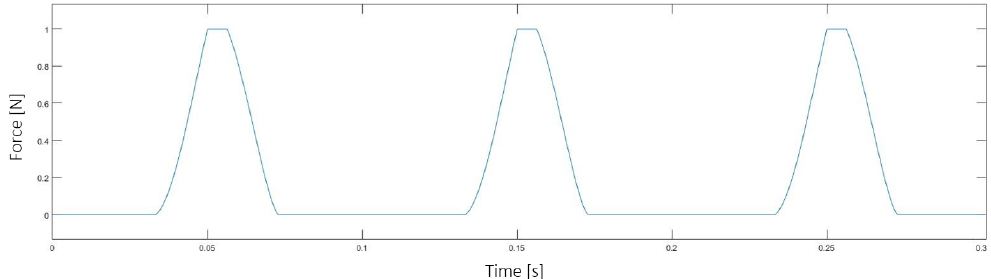
Figure 3. Cutting force model for a single edge cutting tool, with D = 8 mm, a p = 8 mm, a e = 1 mm, f z = 0.08 mm and n = 1200